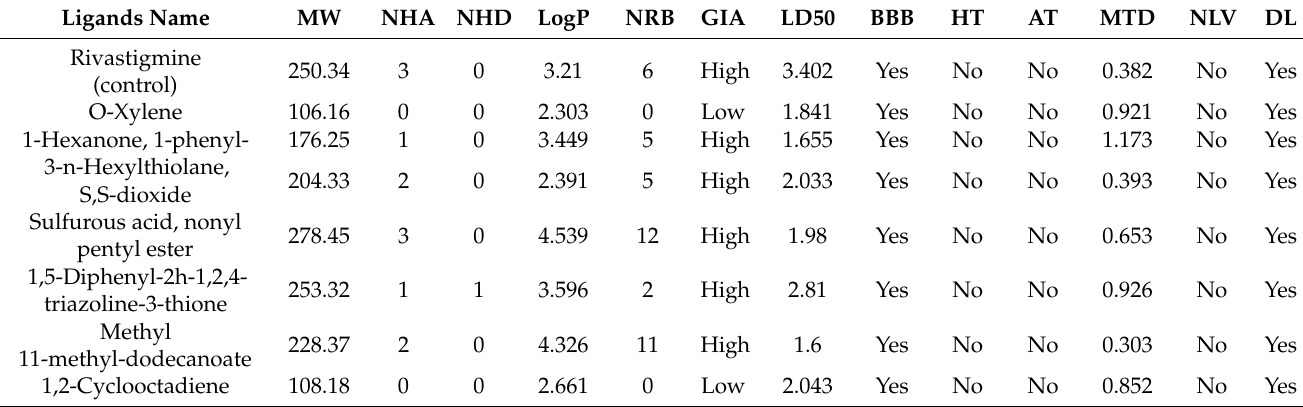
Figure 3. Neurological activity of G. tetrandra in the hole board test (Values are presented as Mean ± SD) ( n = 5), * p < 0.05 compared to control group. Table 2. The pharmacophore and pharmacokinetic profile of the selected ligand